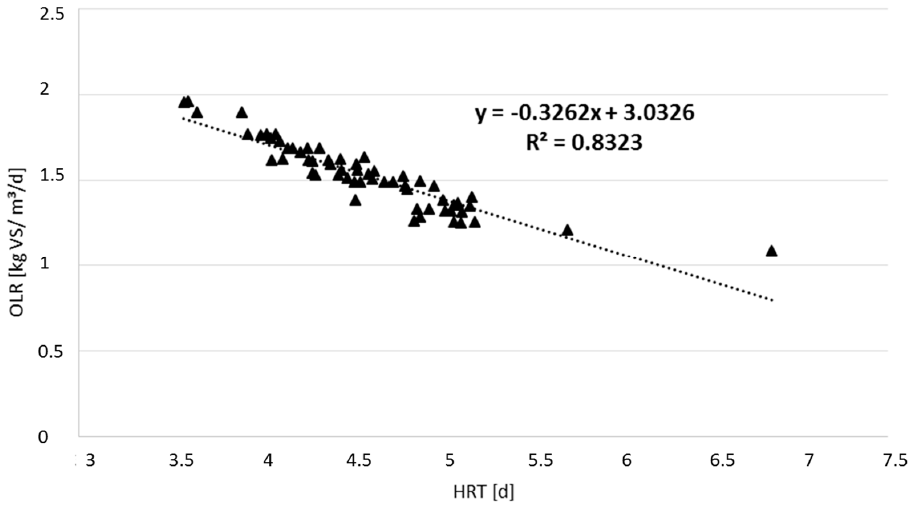
Figure 2. Linear regression of the OLR and the HRT (R = − 0.912; p < 0.05).